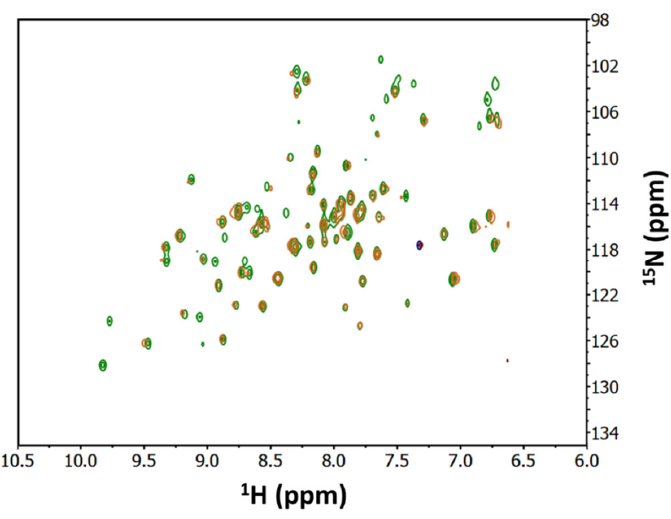
Figure 2. 1 H- 15 N HSQC NMR spectra of 80 µ M 15 N-labeled PSD-95 PDZ3 alone (green) and upon addition of 1:3 hSR (orange). Only the initial (no hSR) and final (1:3 PDZ3:hSR) spectra of the titration are reported.